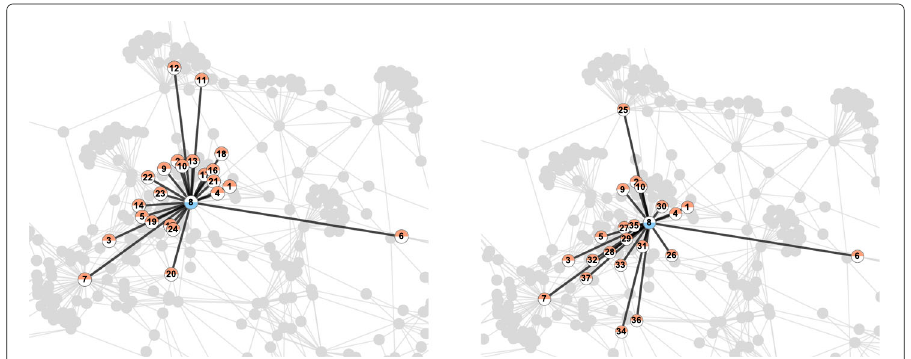
Fig. 9 Two bi-patterns with null homogeneity and sharing the same single star. The star represents Vipin Kumar who is labeled as d ={algorithm,analysy,assocy,data,graph,mine,parallel,partit,pattern,scalabl,search}. The bi-pattern q = (d, {Model}) is displayed on the left while the bi-pattern q (cid:2) = (d, {Network}) is displayed on the right. Some co-authors belong to both bi-patterns, i.e. have both labels, while Vipin Kuma has none of them. See Table 3 the authors associated to these vertices